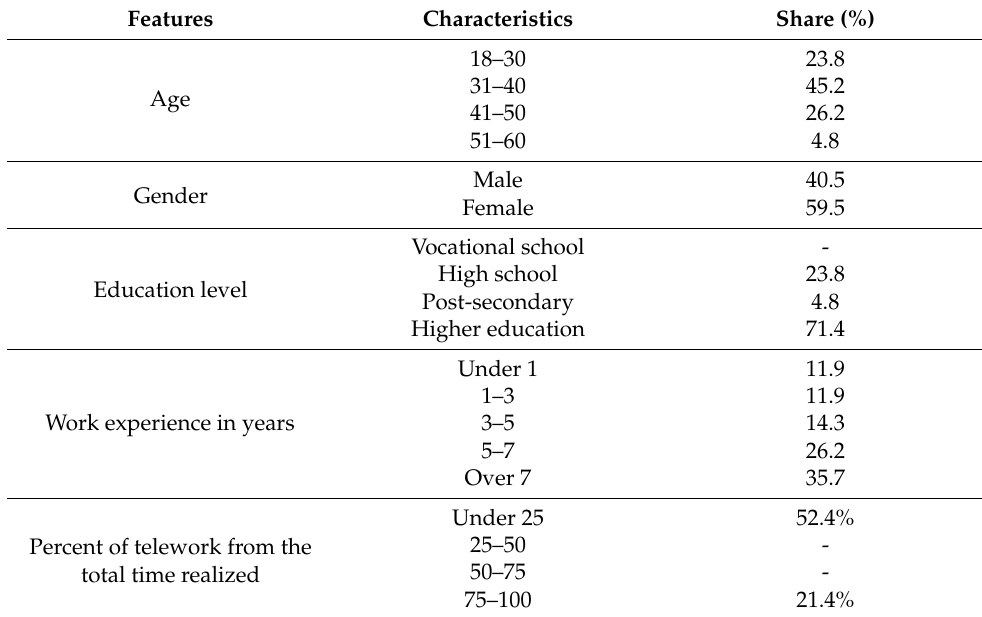
Table 2. Sociodemographic characteristics of the management staff from